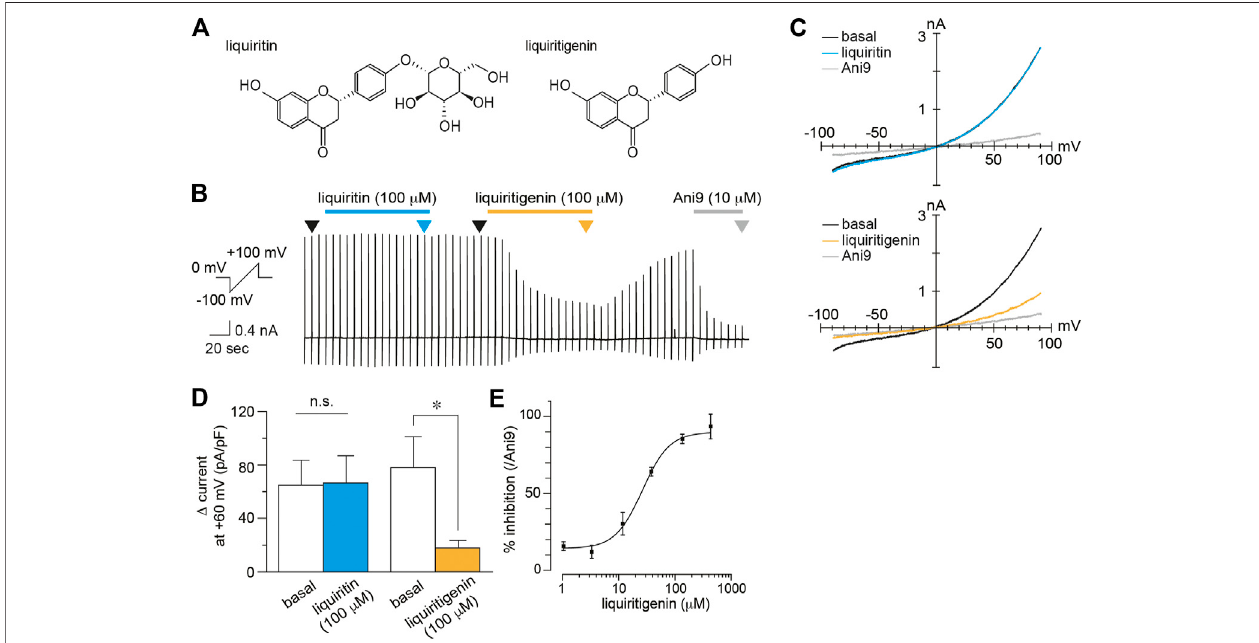
FIGURE1| Inhibition ofmTMEM16A currents byliquiritigenin (A) Chemical structureofliquiritin (left) and liquiritigenin (right) (B – C) Atypical trace (B) and current- voltage curves (C) ofwhole-cell chloride currents during application of 100 µM liquiritin and 100 µM liquiritigenin to HEK293T cells expressing mTMEM16A. The holding potential was 0 mV, and ramp pulses ( − 100 to +100 mV, 300 ms) were applied every 5 s. Basal TMEM16A currents were induced by 100 nM intracellular free calcium. Current-voltage curves at the time indicated by black (basal), cyan (liquiritin), yellow (liquiritigenin), and gray (Ani9) arrowheads in (B) . (D) Comparison of the Δ currentat+60 mV(liquiritin;n (cid:2) 7 cells,liquiritigenin;n (cid:2) 8cells).Dataareshownasthemean ± SEM;* p < 0.05,n.s.,notsigni fi cant,Wilcoxonmatched-pairssignedrank test (E) Dose-response curve for liquiritigenin-induced inhibition of mTMEM16A currents at +60 mV (n (cid:2) 5 – 6 cells). The IC 50 was 21.32